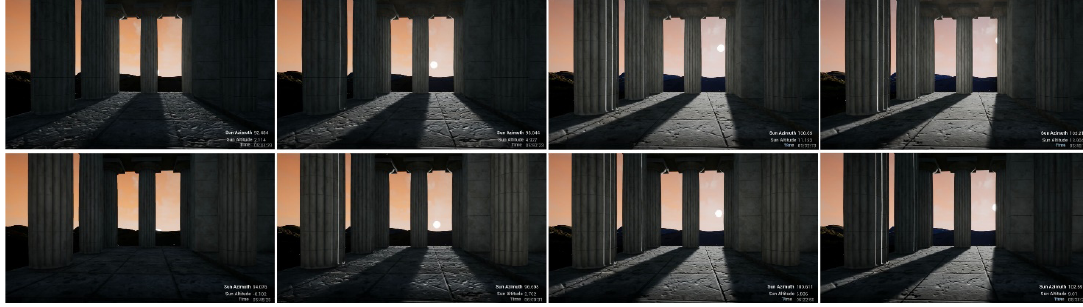
Figure 7. Virtual reality simulation model of the temple’s exterior between 500–100 BCE. Top row: progression of sunbeam at equinoxes. Bottom row: progression of sunbeam a week before the